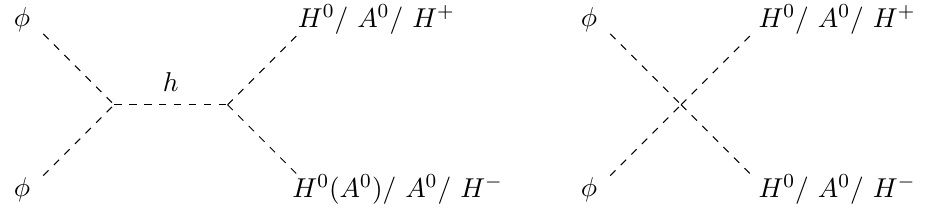
Figure 8 . DM ! DM conversion processes in a model with (cid:30) and H 0 . We have assumed m (cid:30) > m ; m ; m here. The reverse processes occur with reverse H 0 A 0 H (cid:6)